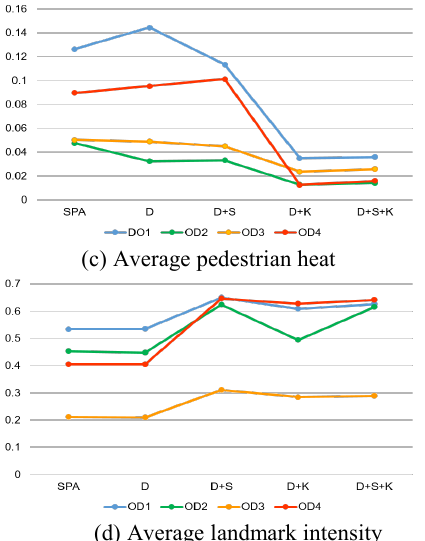
Figure 7. Compare of routes forming with different heuristic